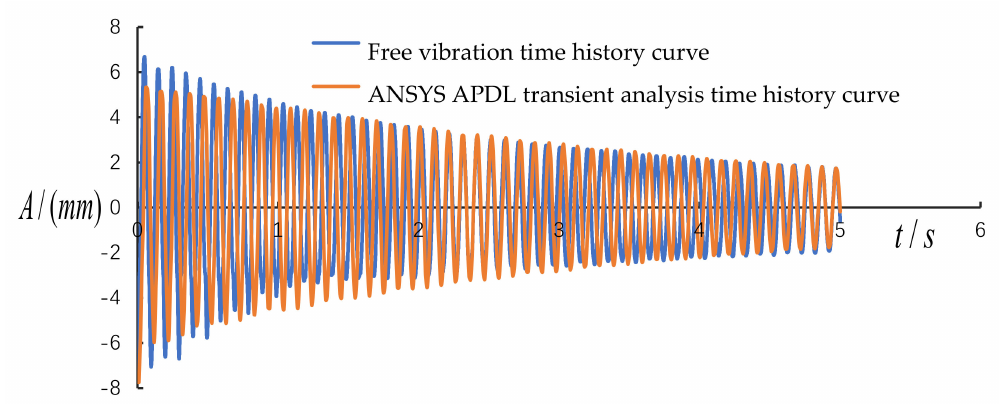
Figure 5. Comparison chart of free vibration and ANSYS APDL transient analysis time history curve.